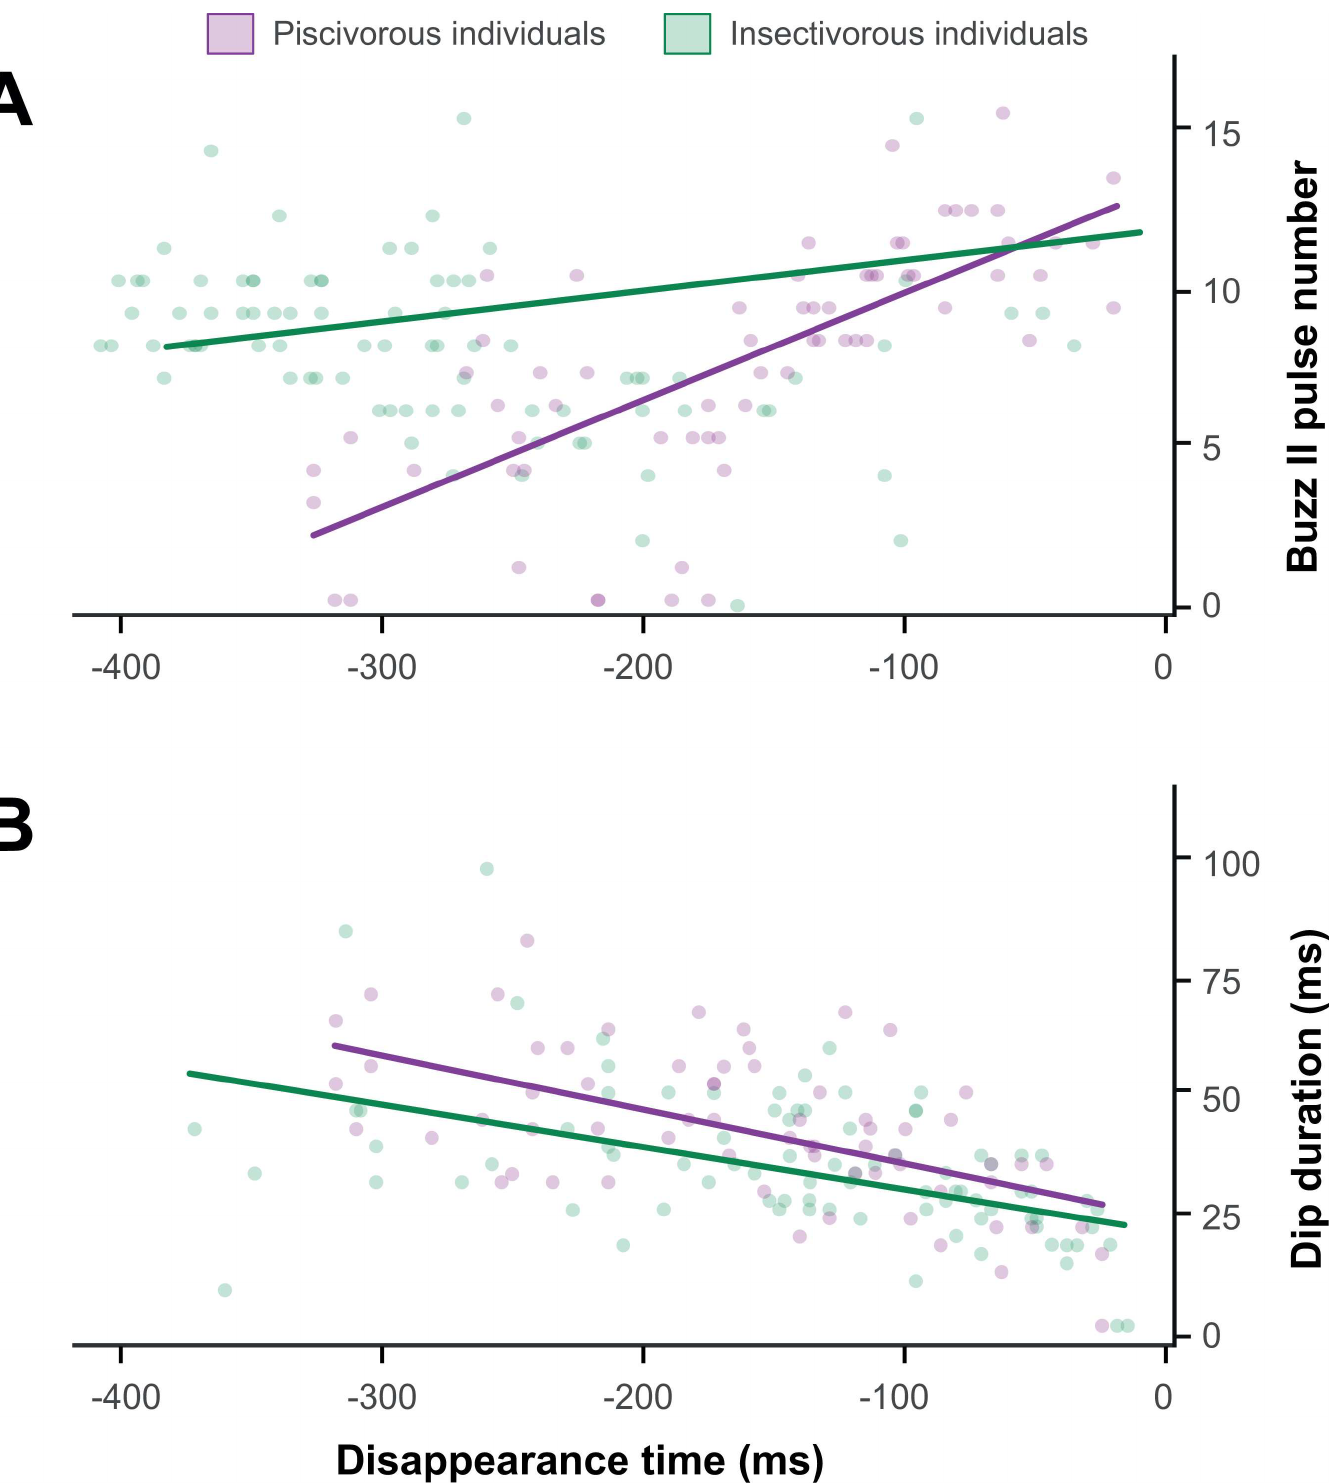
Fig 3. The relationships between (A) number of pulses in buzz II and fish disappearance time and (B) dip duration and fish disappearance time. The moment of capture is presented as 0 ms (on the right side of the graph). (A) The sooner disappearance of the target produces a decreasein the number of buzz II pulses in both piscivorous and insectivorous individuals, even thoughthe trend is more pronounced in piscivorous individuals. (B) The sooner disappearance of the target produces a similar increase in the durationof the dip in both piscivorous and insectivorous individuals.